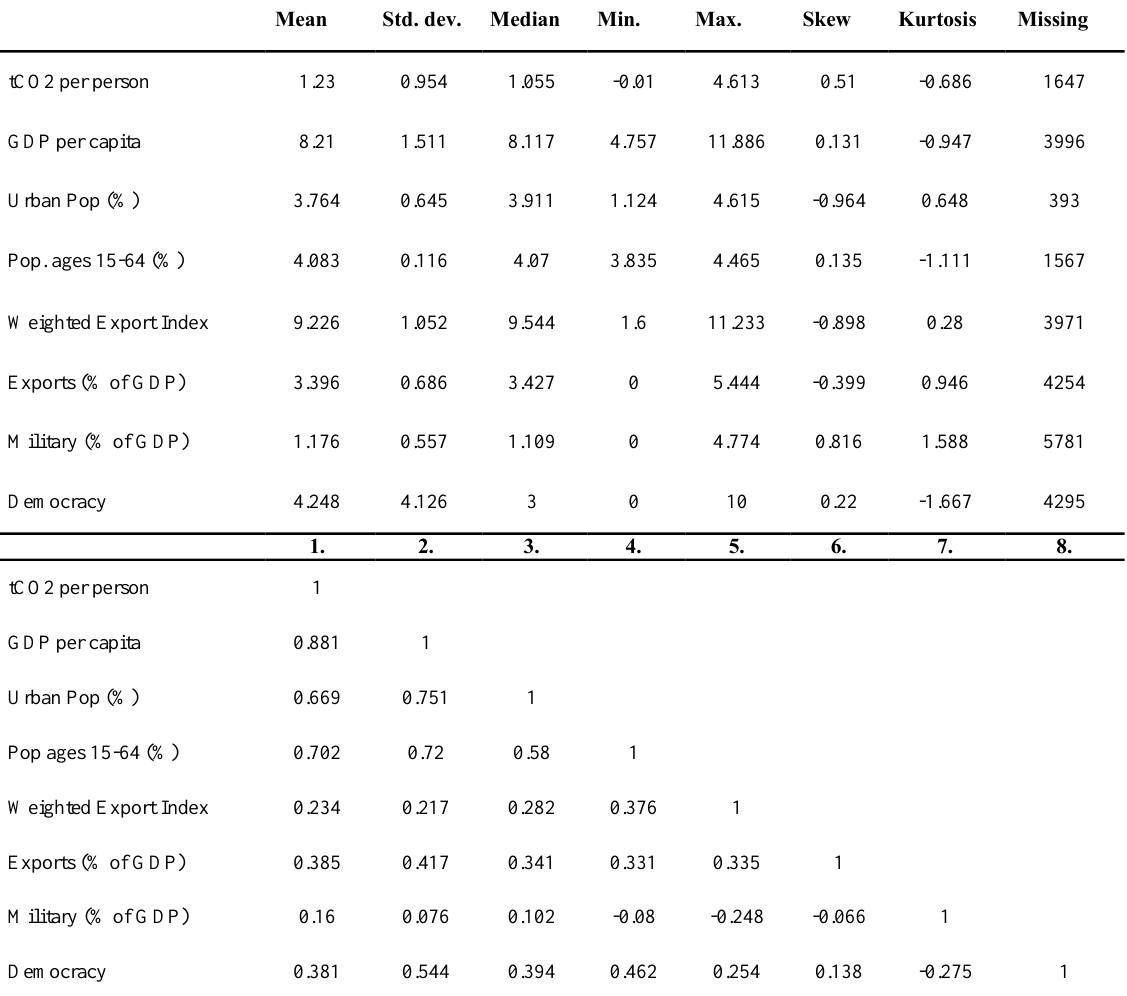
Table 2. Summary Statistics and Correlation